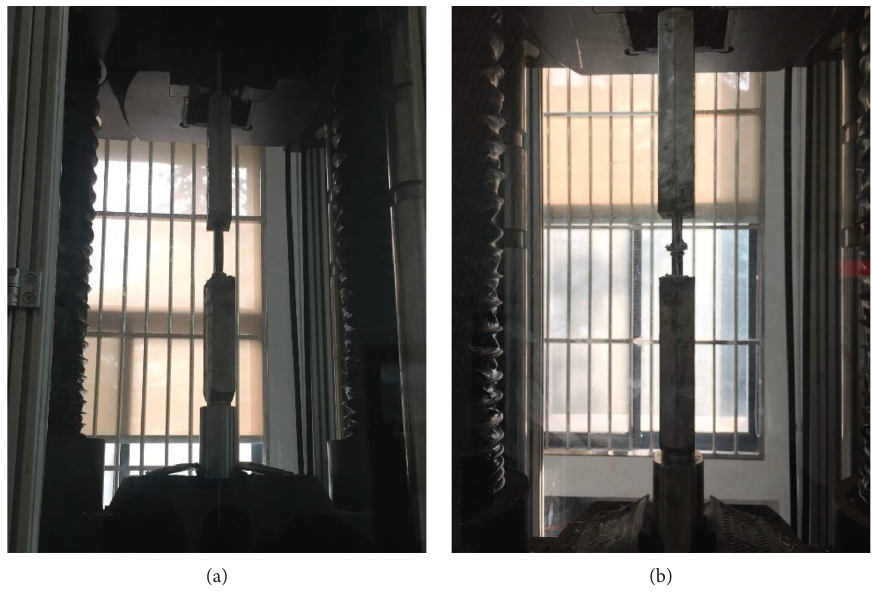
Figure 6: Cable rotation occurring in the testing process. (a) T1. (b)